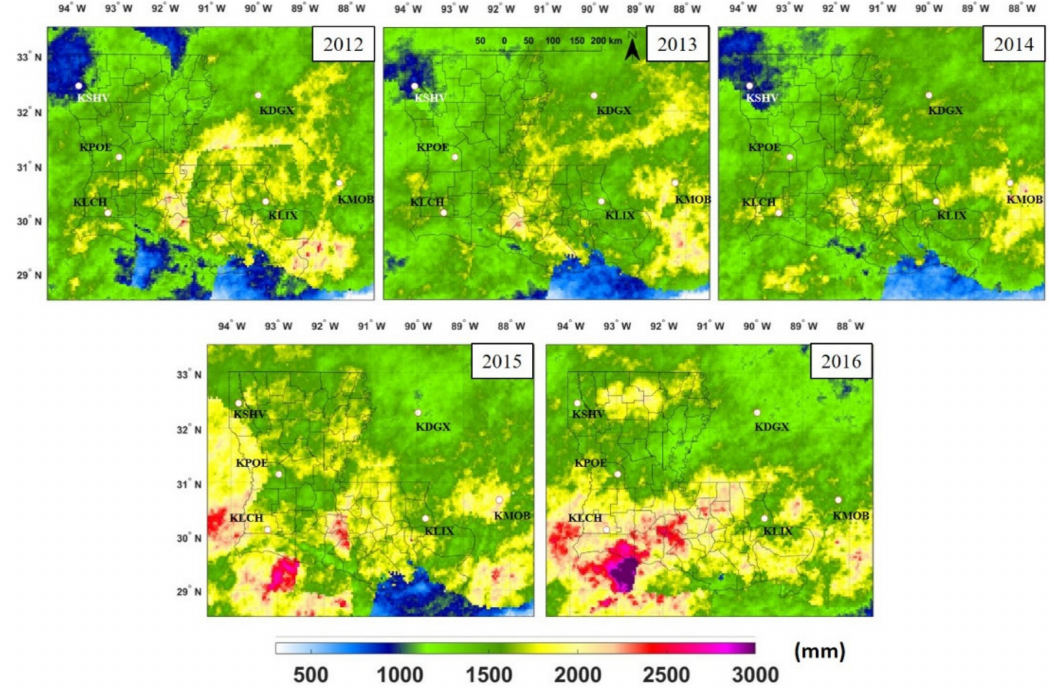
Figure 3. Stage IV spatial rainfall accumulation maps in millimeters for the years 2012 through 2016 over the state of Louisiana. The white dots represent the locations of the di ff erent NWS NEXRAD radars.